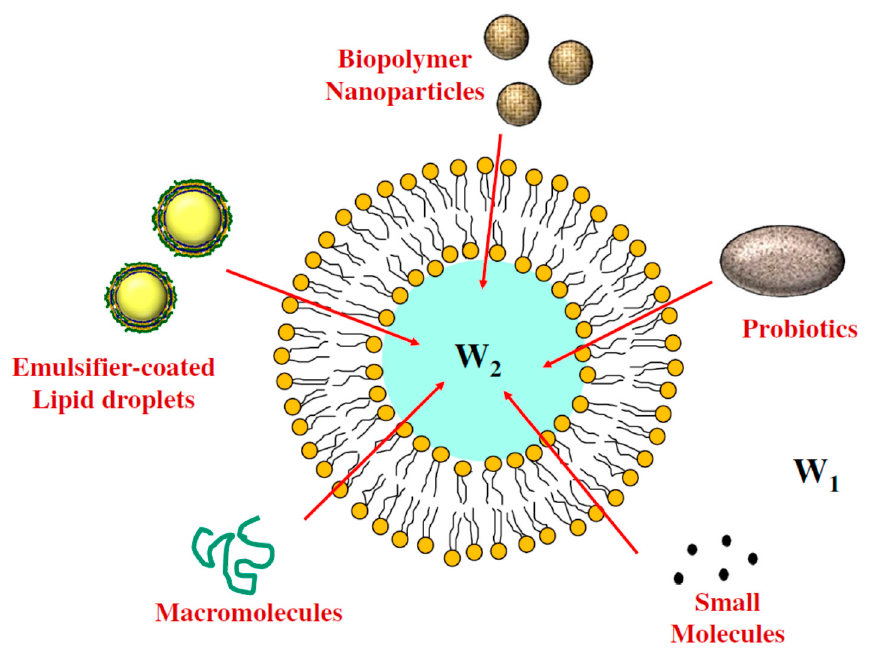
Figure 4. Incorporation of different hydrophilic bioactive agents into the hydrophilic interiors (W2) of liposomes